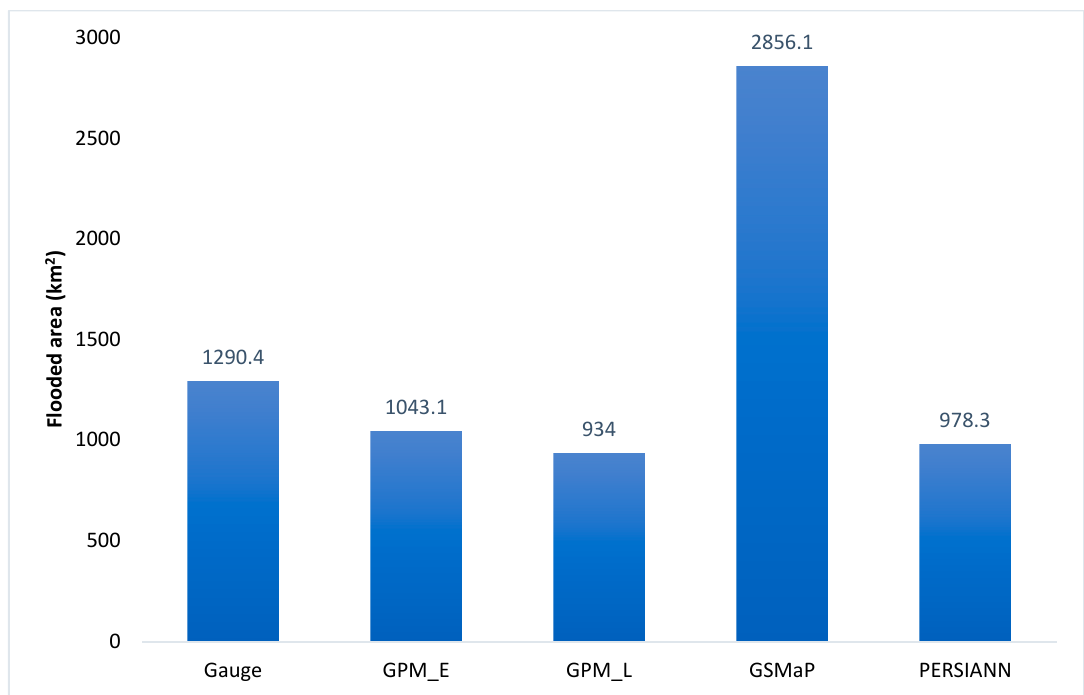
Figure 8. Comparison of flooded area at downstream derived using hydrological model using different satellite precipitation products and rain gauge data.